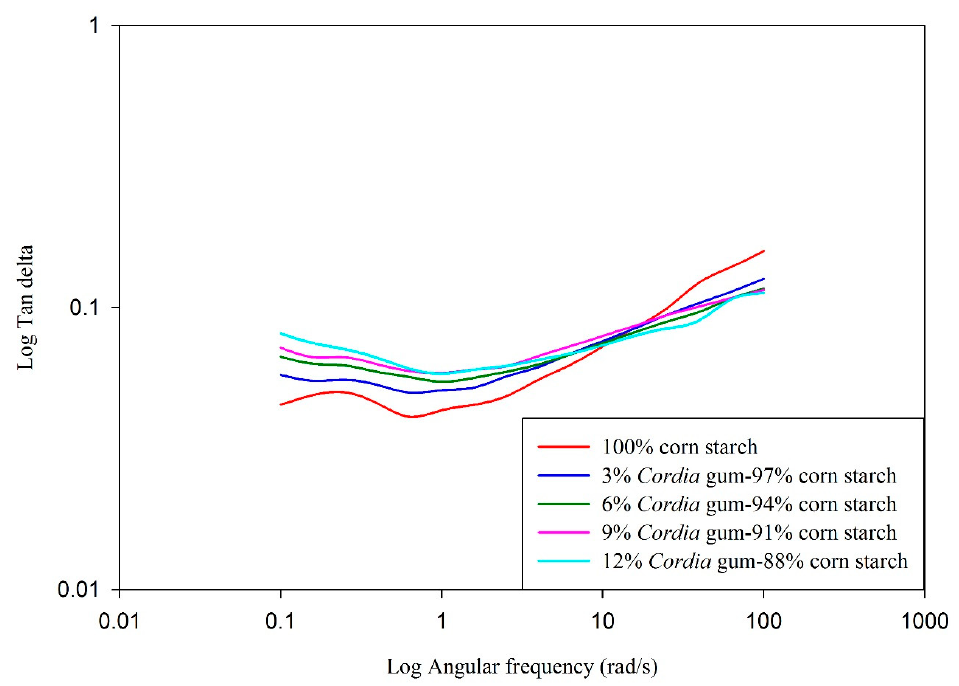
Figure 3. Effect of gum Cordia on the loss modulus (G ″ ) of corn starch gels. Figure 3. E ff ect of gum Cordia on the loss modulus (G”) of corn starch gels.